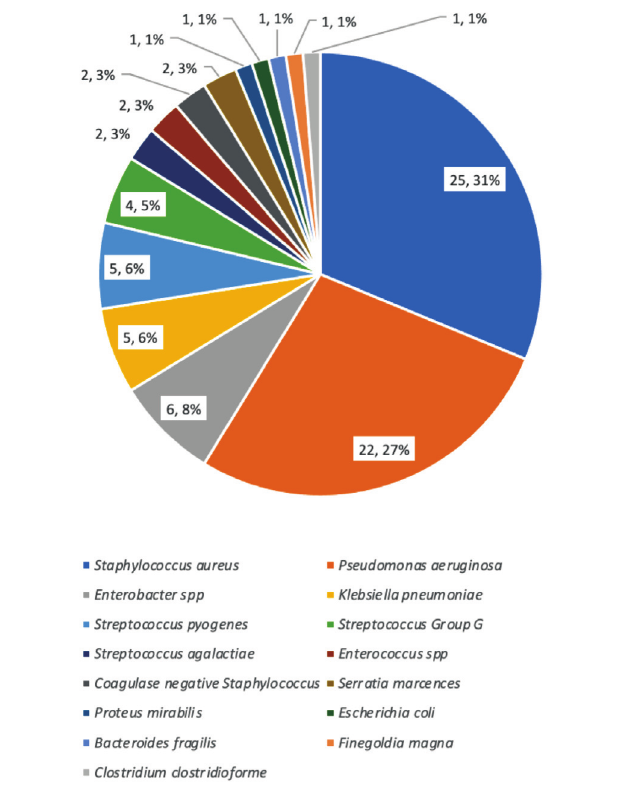
Fig. 1: Etiological agents of orthopaedic SSI.